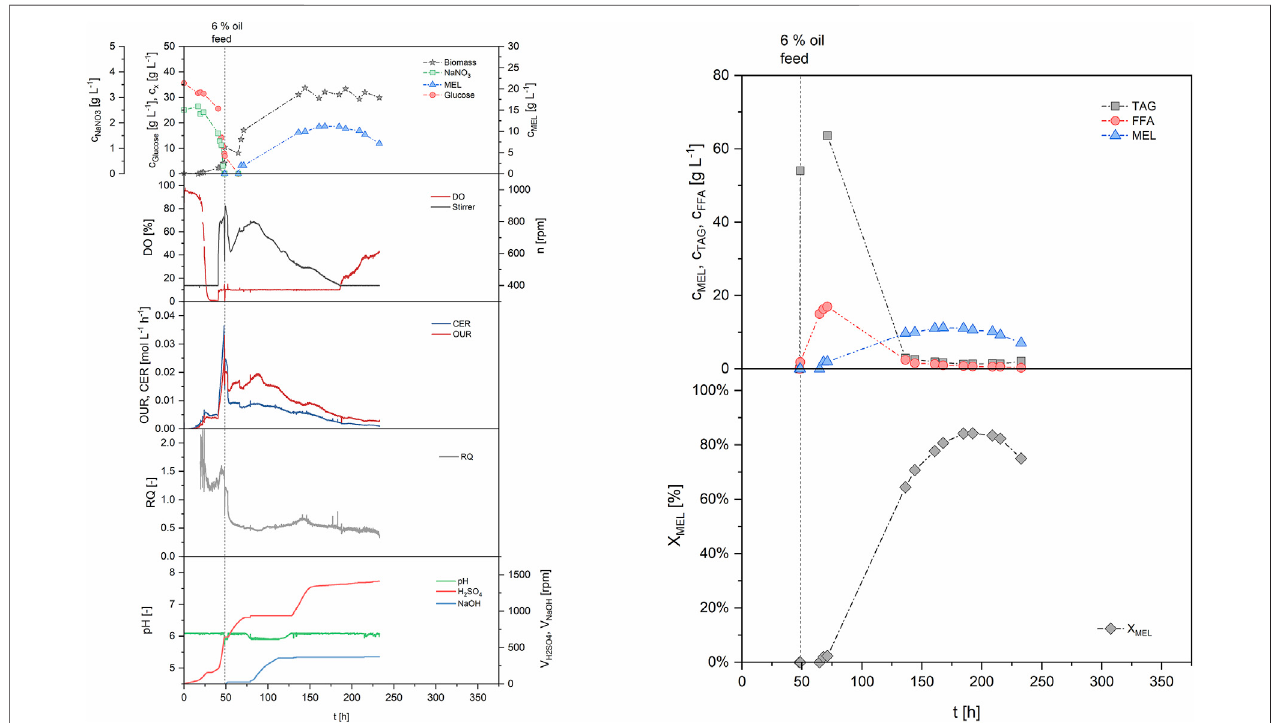
FIGURE 5 | Process data for the two-staged batch (B1). Growth was performed in batch mode, and production was initiated at 48 h using 6% v/v rapeseed oil as substrate.